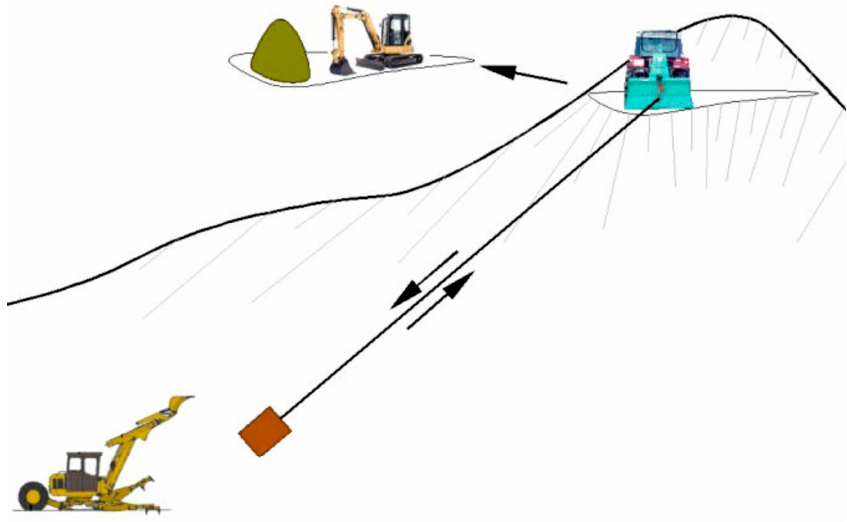
Figure 2. The on-site sampling procedure of the waste rock dumps.